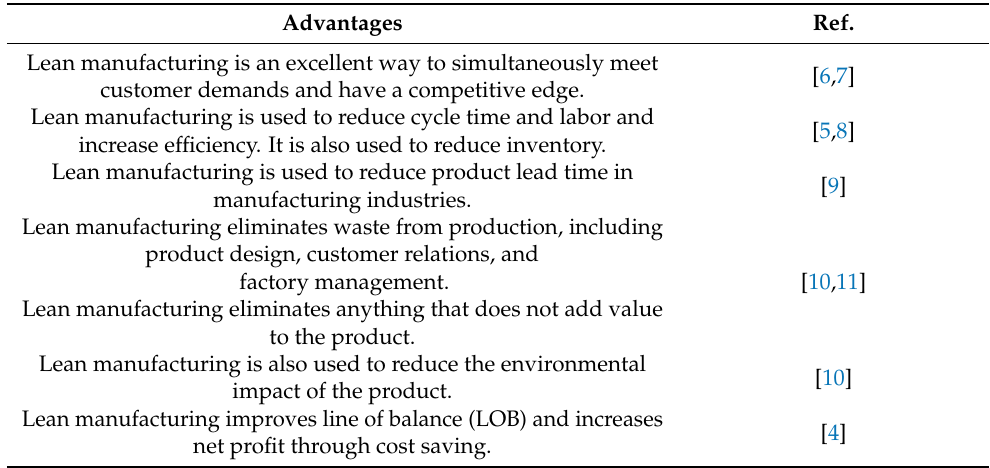
Table 1. Lean manufacturing and its outcome. Advantages